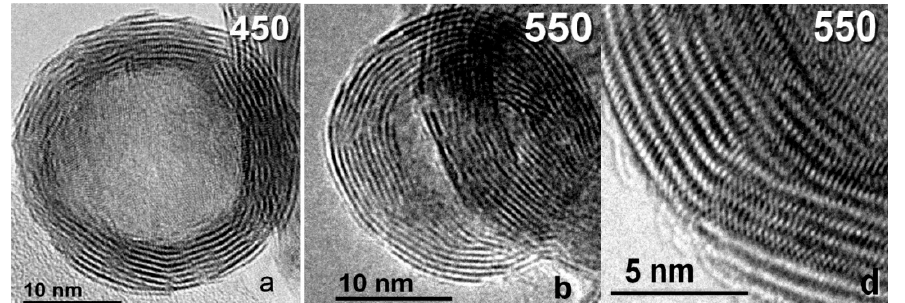
Figure 4. Taken and modified from [37], high resolution transmission electron microscopy (HRTEM) images of hollow spheres prepared by P. Afanasiev.